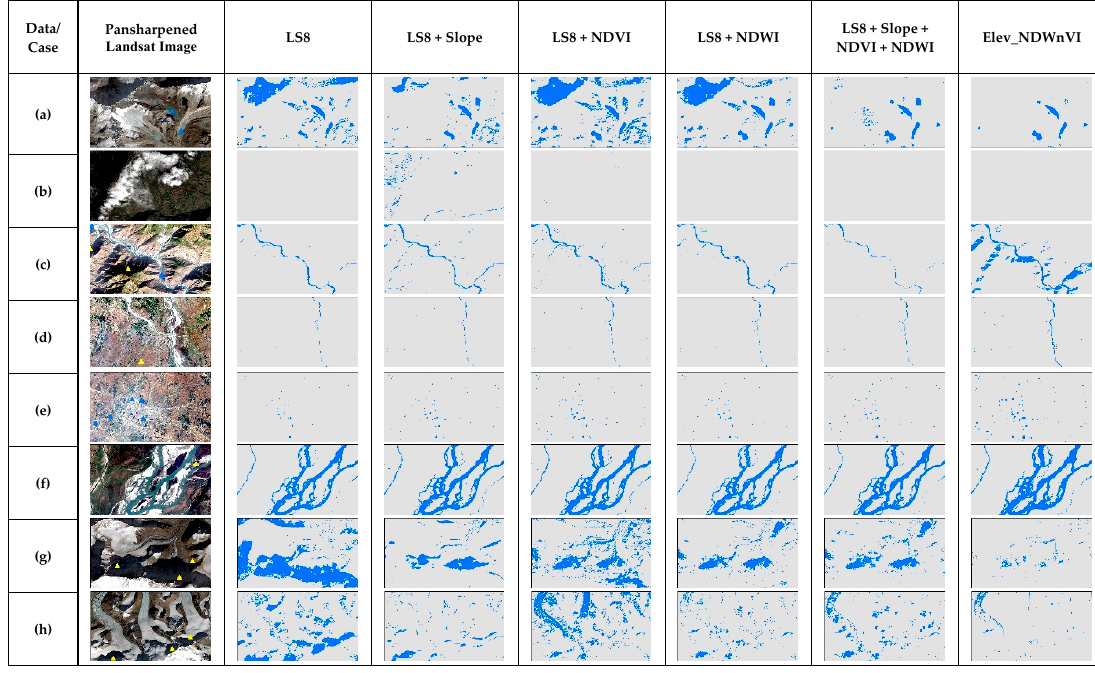
Figure 7. The comparison of RPART results of special cases of surface water in the test scene (Figure 1) for different multiband data used. for di ff erent multiband data